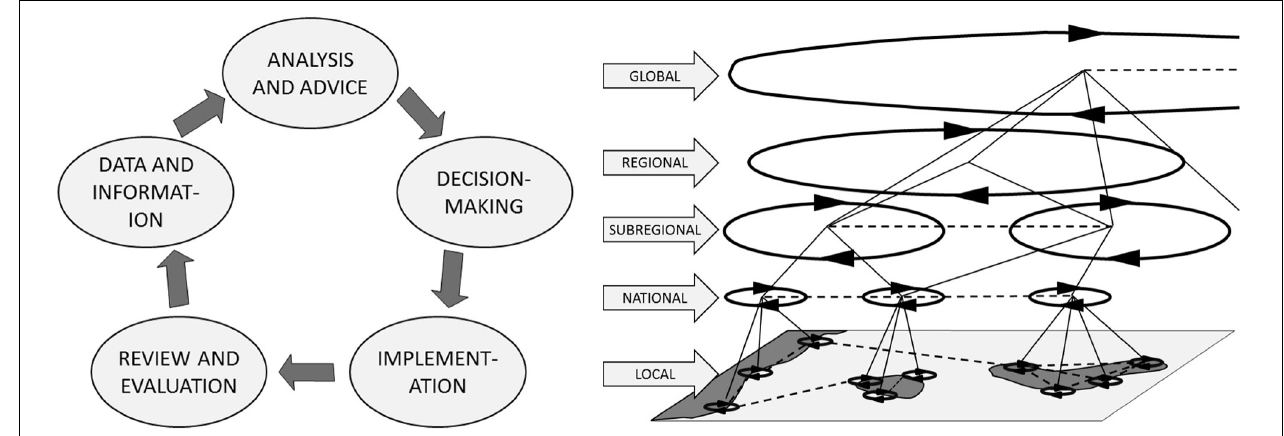
FIGURE 2 | The LME Governance Framework showing the five stages of the policy cycle component on the left and the multi-level component showing the vertical and lateral linkages needed for policy cycles to facilitate effective governance at the LME level (represented by ovals on the